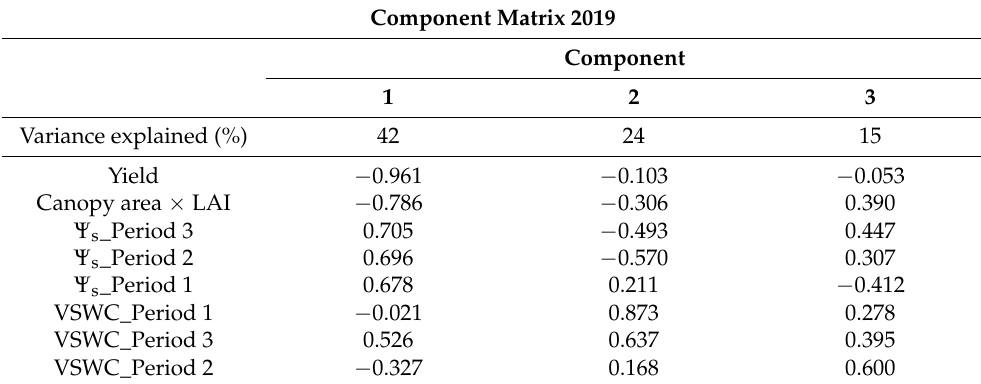
Table A2. Principal component matrix for different variables (sorted by size) and variance explained by each principal component for 2019.